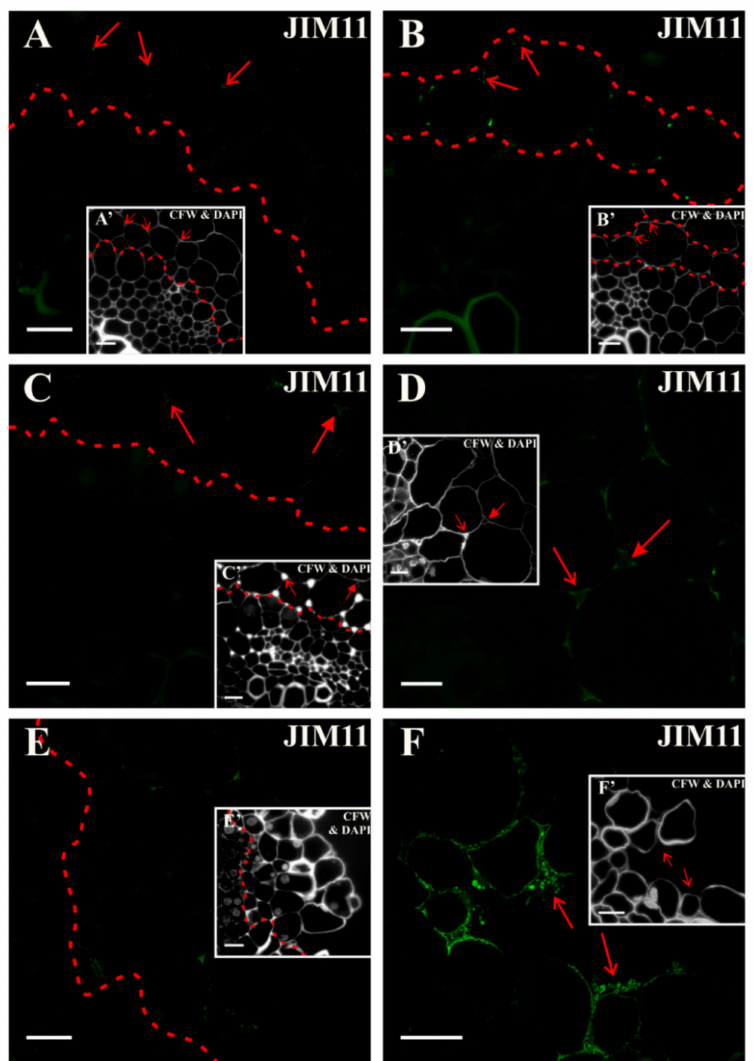
Figure 11. Distribution of the extensin epitope that is detected by the JIM11 antibody. ( A ) At the beginning of the culture, the signal was detected only at the junction of the walls between the cells that are located outside the pericycle (arrows; the dashed line separates the area of the occurrence of the epitope). ( B , C ) In the following days of the culture ( B —two days, C —four days), the signal was distributed in a similar pattern as in previous days (areas marked with dashed lines, arrows point to intercellular